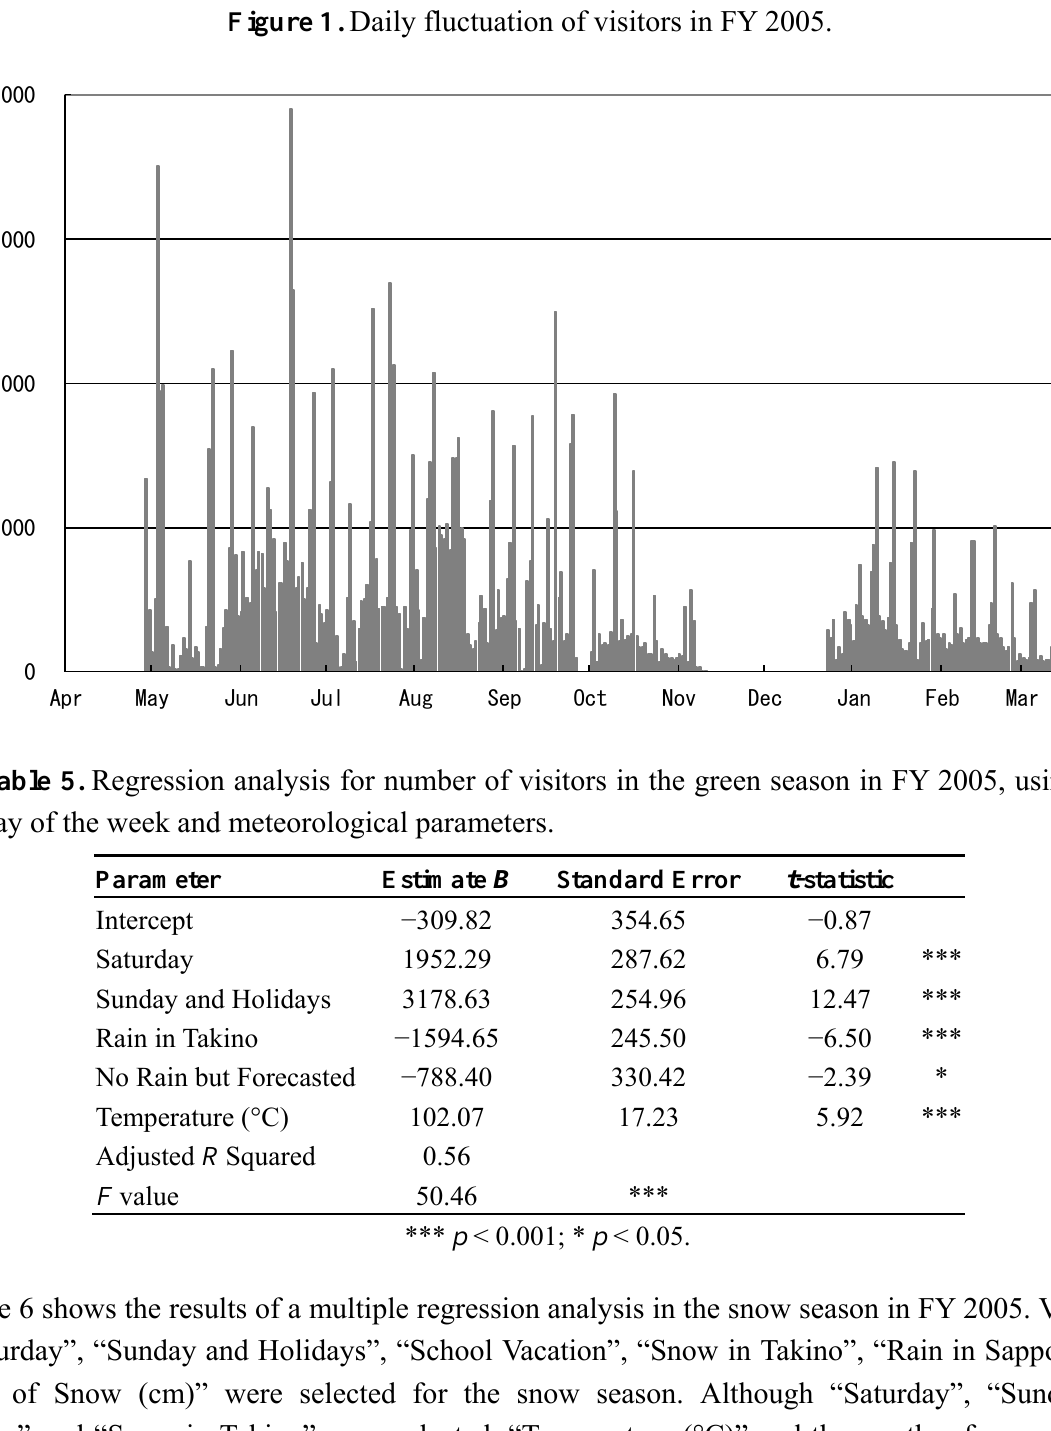
Figure 1. Daily fluctuation of visitors in FY 2005.